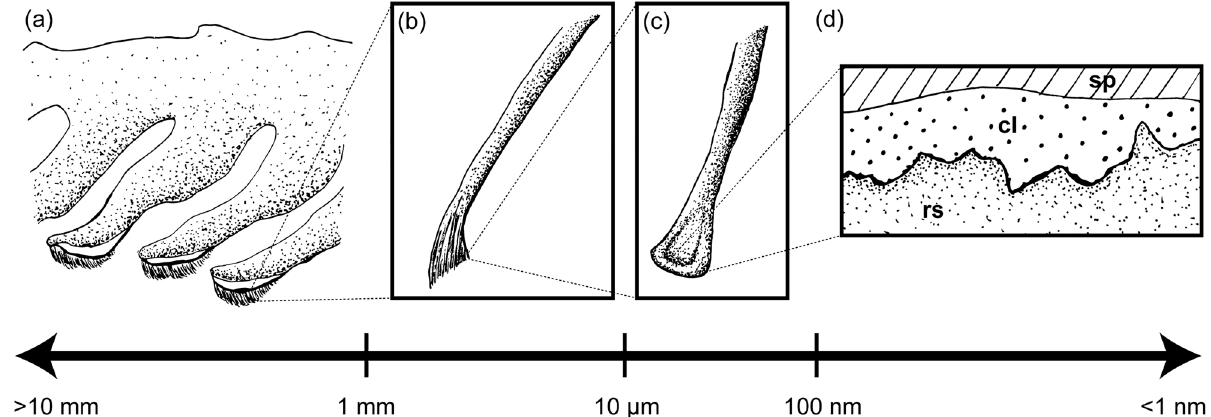
Figure 4. Illustration of which levels of the gecko adhesive hierarchy deform to wavelengths (λ) of roughness from the millimetre to nanometre scale as described by Persson 28 . ( a ) The skin and underlying digital anatomy conform to surface roughness wavelengths of 1 mm and longer. ( b ) Gecko setae conform to roughness wavelengths between 10 μm and 1 mm. ( c ) Spatulae conform to surface roughness between wavelengths of 100 nm and 10 μm. ( d ) Persson 28 proposed a thin, conformal layer on gecko spatulae that conforms to surface roughness wavelengths of 100 nm and shorter; sp = spatula; cl = conformal layer; rs = rough surface. Figure not drawn to scale.